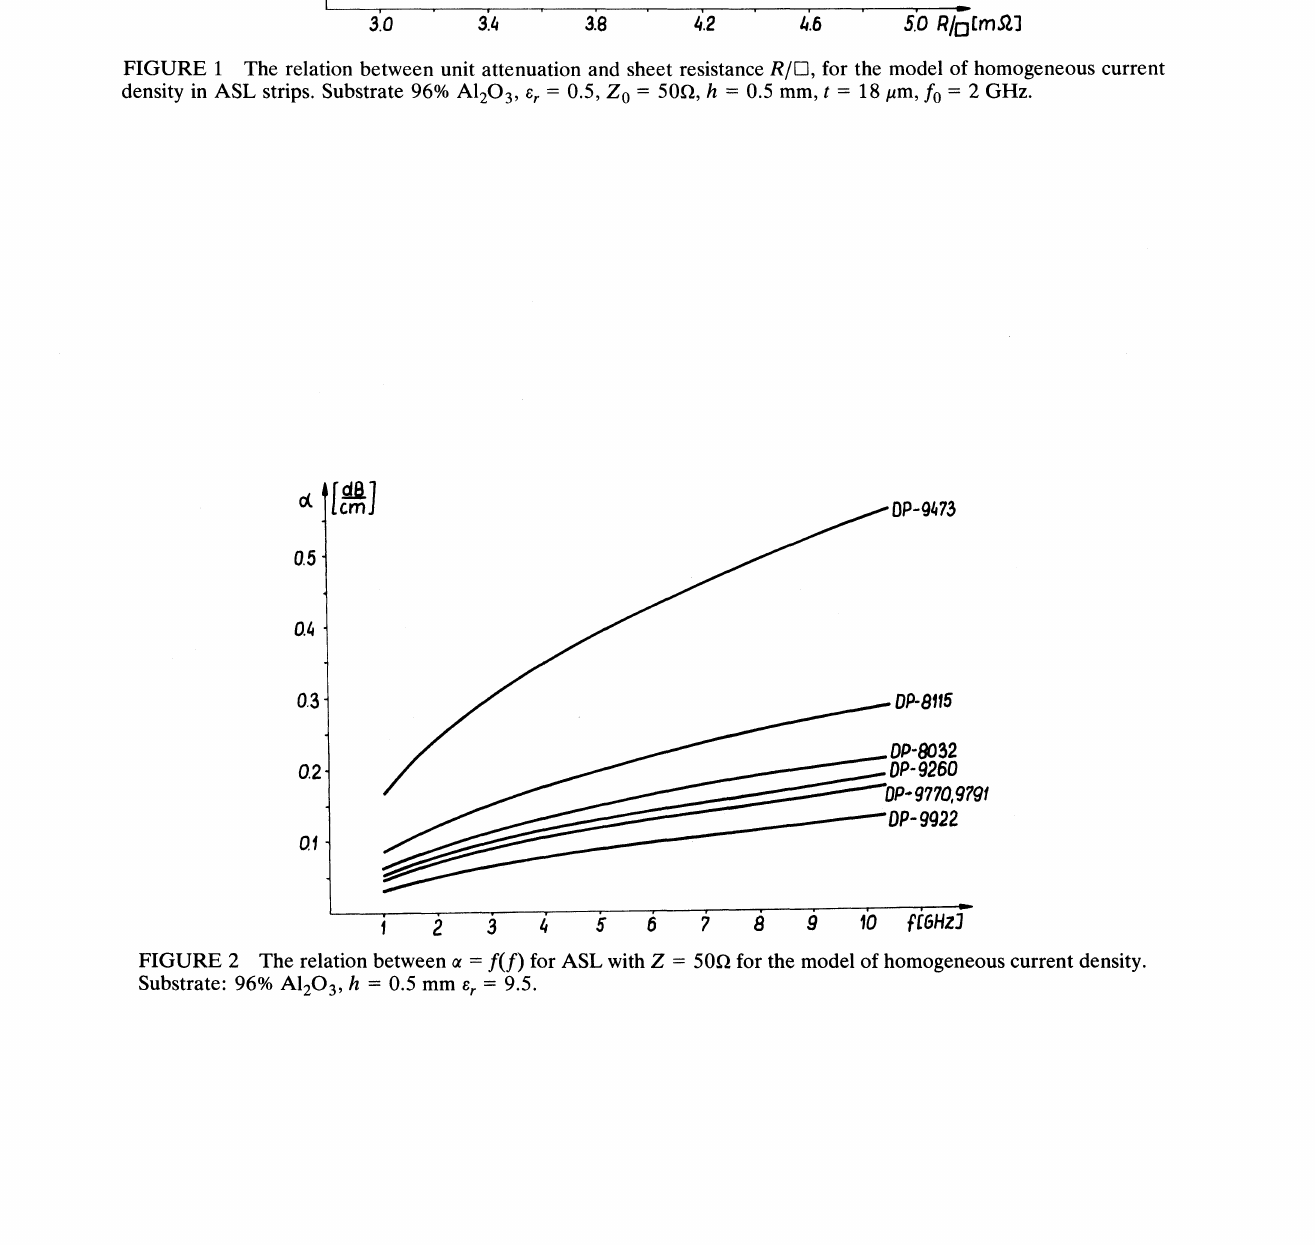
The relation between unit attenuation and sheet resistance R/C], for the model of homogeneous current er 0.5, Z density in ASL strips. Substrate 96% A120 0 50, h 3,